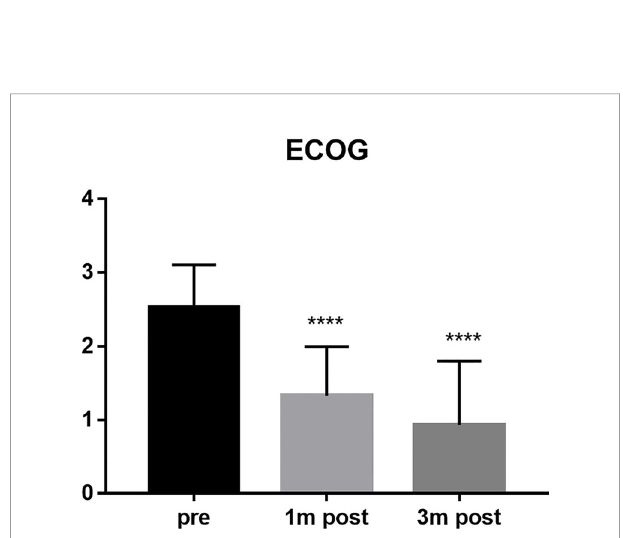
FIGURE 5 | Overall survival rate compared the en-bloc resection and sub- total